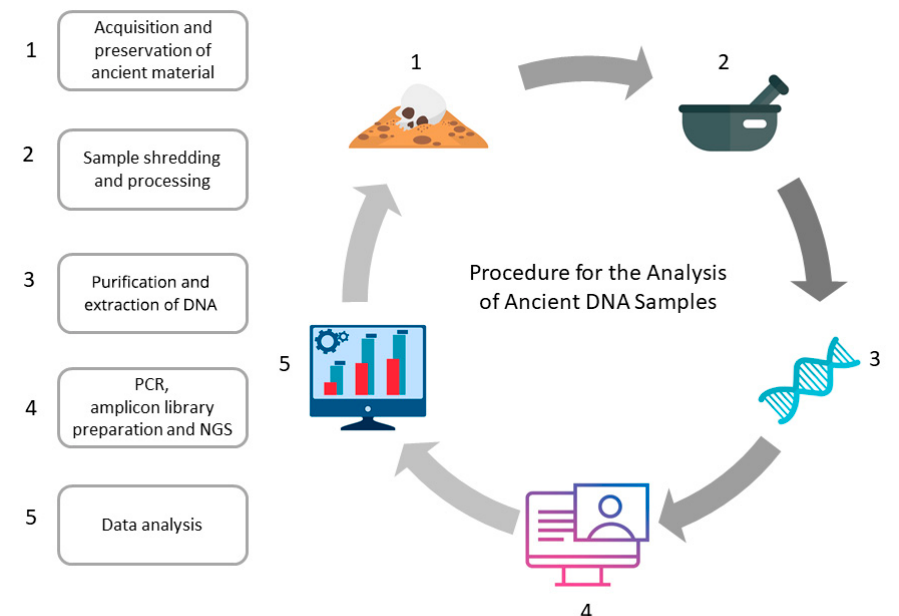
Figure 1. General workflow of aDNA analysis. The figure shows the order of tasks in a project re ‐ garding recovering ancient genetic material. Steps 1–4 are related to direct work with the samples either on site or in a laboratory (when potential contamination may occur); step 5 includes bioinfor ‐ matic analysis, which, while represented by only a single step, is usually no less time ‐ consuming than the other four combined. The results obtained through data analysis may indicate samples of particular interest (e.g., samples that could be re ‐ sequenced with high coverage).